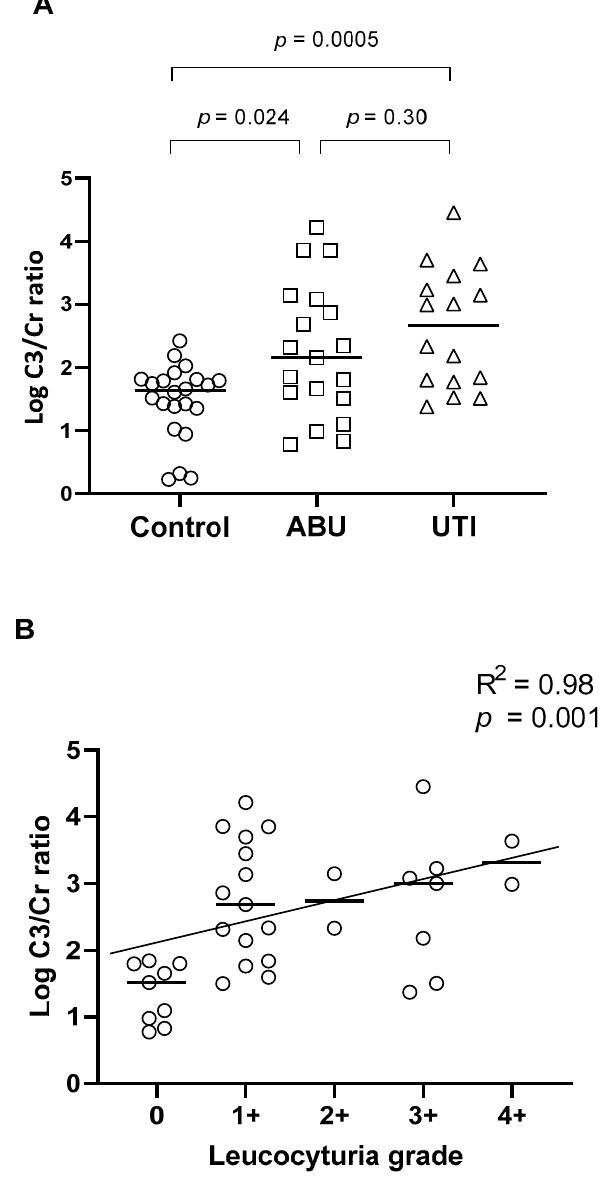
Figure 3. ( A ) Log complement C3/Cr (creatinine) ratio for urine from control (patients without symptoms and sterile urine), asymptomatic bacteriuria (ABU) and urinary tract infection (UTI). p -values for comparisons as indicated shown on top. ( B ) Linear correlation between leukocyturia measured as grades (0, no leucocytes, 4+, highest concentration of leucocytes; bars show medians) versus log C3/Cr ratio. Correlation coefficient squared (R 2 ) and p -value indicated in figure.